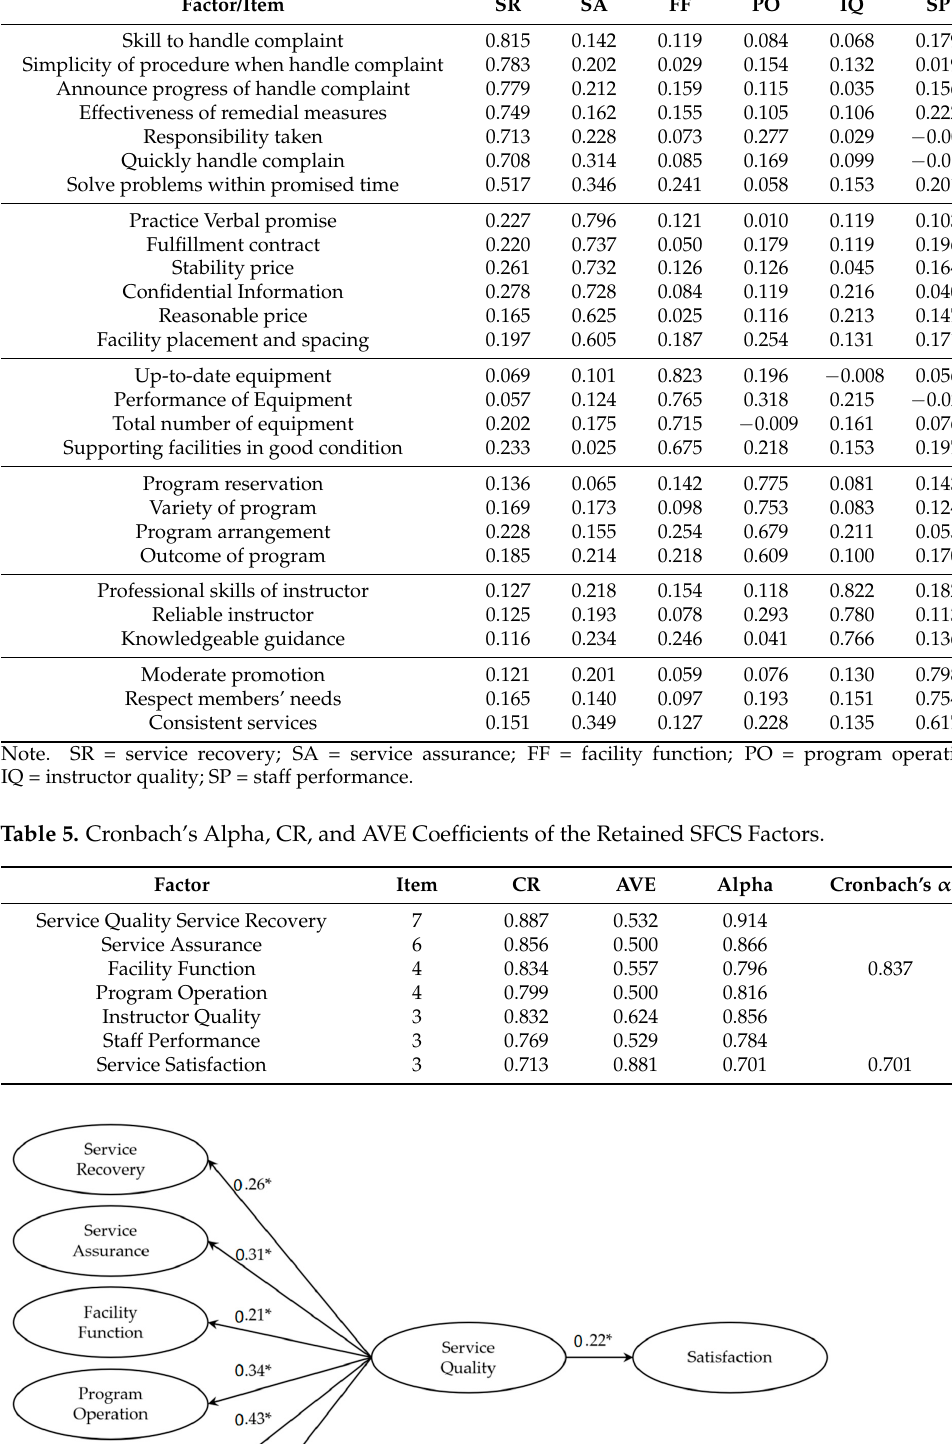
Table 4. Exploratory Factor Analysis with Maximum Likelihood Extraction and Varimax Rotation.